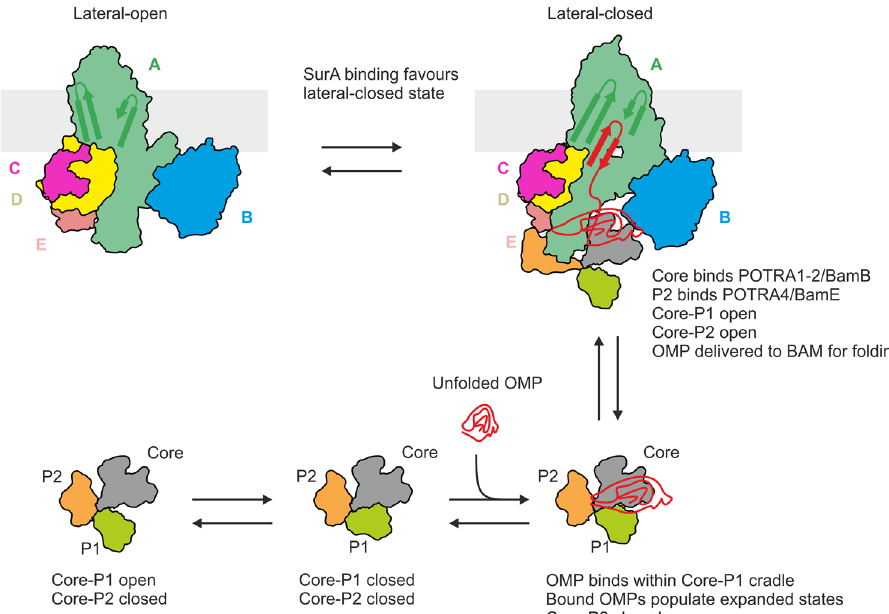
Fig. 6 Proposed model of SurA-mediated delivery of OMPs to BAM for folding. In the membrane, BAM is in dynamic equilibrium, populating a number of conformations including those in which the BamA barrel is in either a ‘ lateral-open ’ or ‘ lateral-closed ’ conformation (top). SurA is also dynamic, populating ‘ Core-P1 open ’ and ‘ Core-P1 closed ’ ensembles of states (bottom). The P2 domain is shown residing close to the core domain in solution ( ‘ Core-P2 closed ’ ). OMPs bind in a cradle formed by the Core and P1 domains, with binding sites primarily located on the core domain 30,31 . OMP binding to SurA causes the OMP to populate expanded states 31,34,35 The OMP – SurA complex binds to BAM, to form an OMP – SurA – BAM ternary complex, resulting in conformational changes in both SurA (opening of the P1 and P2 domains) and BAM (favouring the lateral-closed state, which we propose to be the OMP acceptor state). The OMP binding cradle of SurA is oriented into the BAM periplasmic ring, allowing release of the unfolded OMP into a protective ‘ chaperonin-like ’ environment 5 , and presentation of the OMP to the BamA β -barrel for folding in a C- to N-terminus direction via β -strand elongation from β 1 of the BamA barrel 5,52,53,59,61,114 . Here, a single β -hairpin of the substrate is depicted bound to β 1 of the BamA barrel, however more extensive β -sheet structure in the substrate may begin to form in the periplasm (or at the water – membrane interface) prior to membrane integration 5,53,114,115 , in a manner analogous to a seeded amyloid aggregation reaction 5,116,117